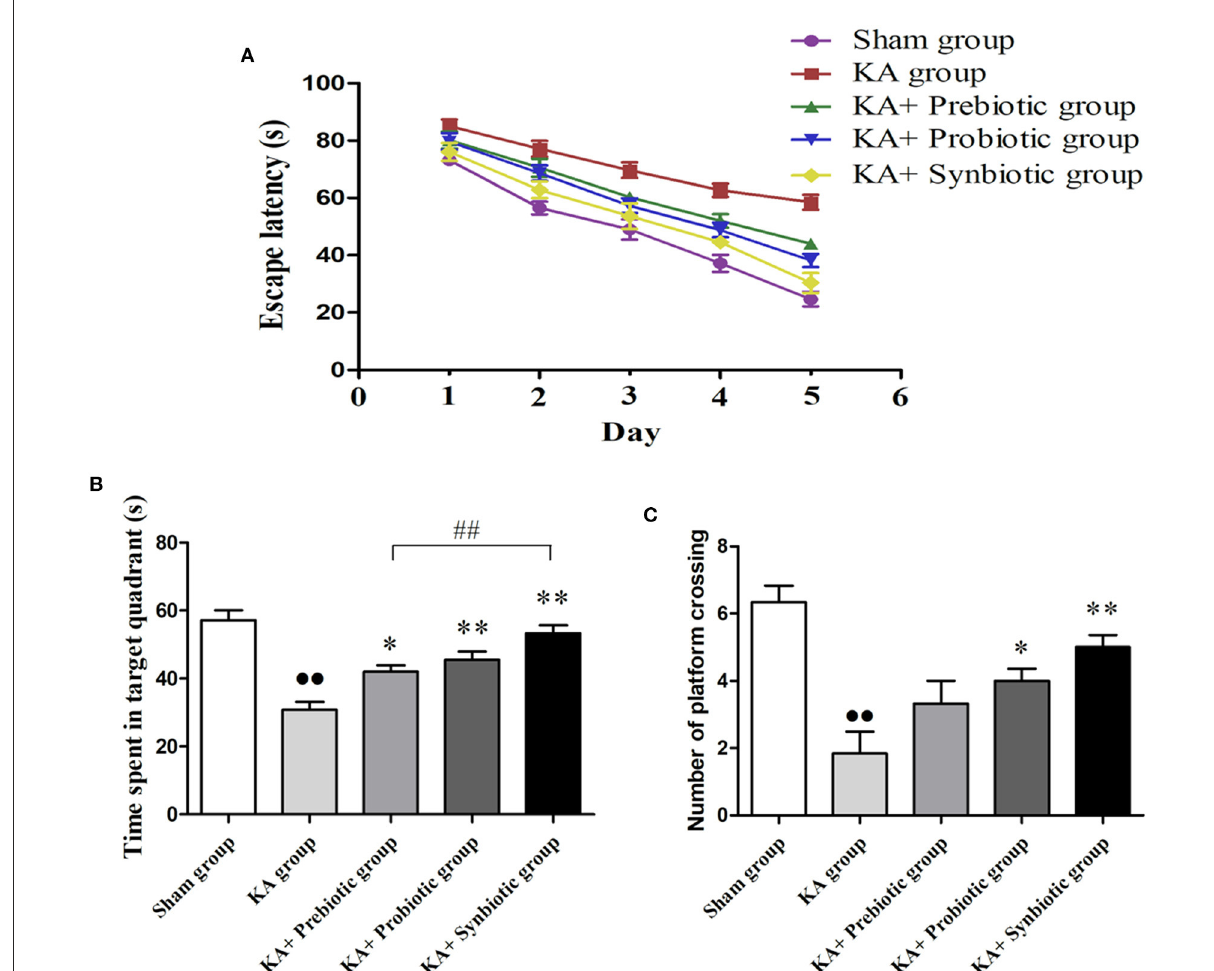
FIGURE2 Effect of prebiotics, probiotics, and synbiotics on cognitive function in rats following status epilepticus induction. (A) Escape latency. (B) Time spent in the target quadrant. (C) Number of platform crossings. •• P < 0.01 vs. the Sham group, * P < 0.05 vs. the KA group, ** P < 0.01 vs. the KA group, ## P < 0.01 vs. the KA + synbiotic group. KA, kainic